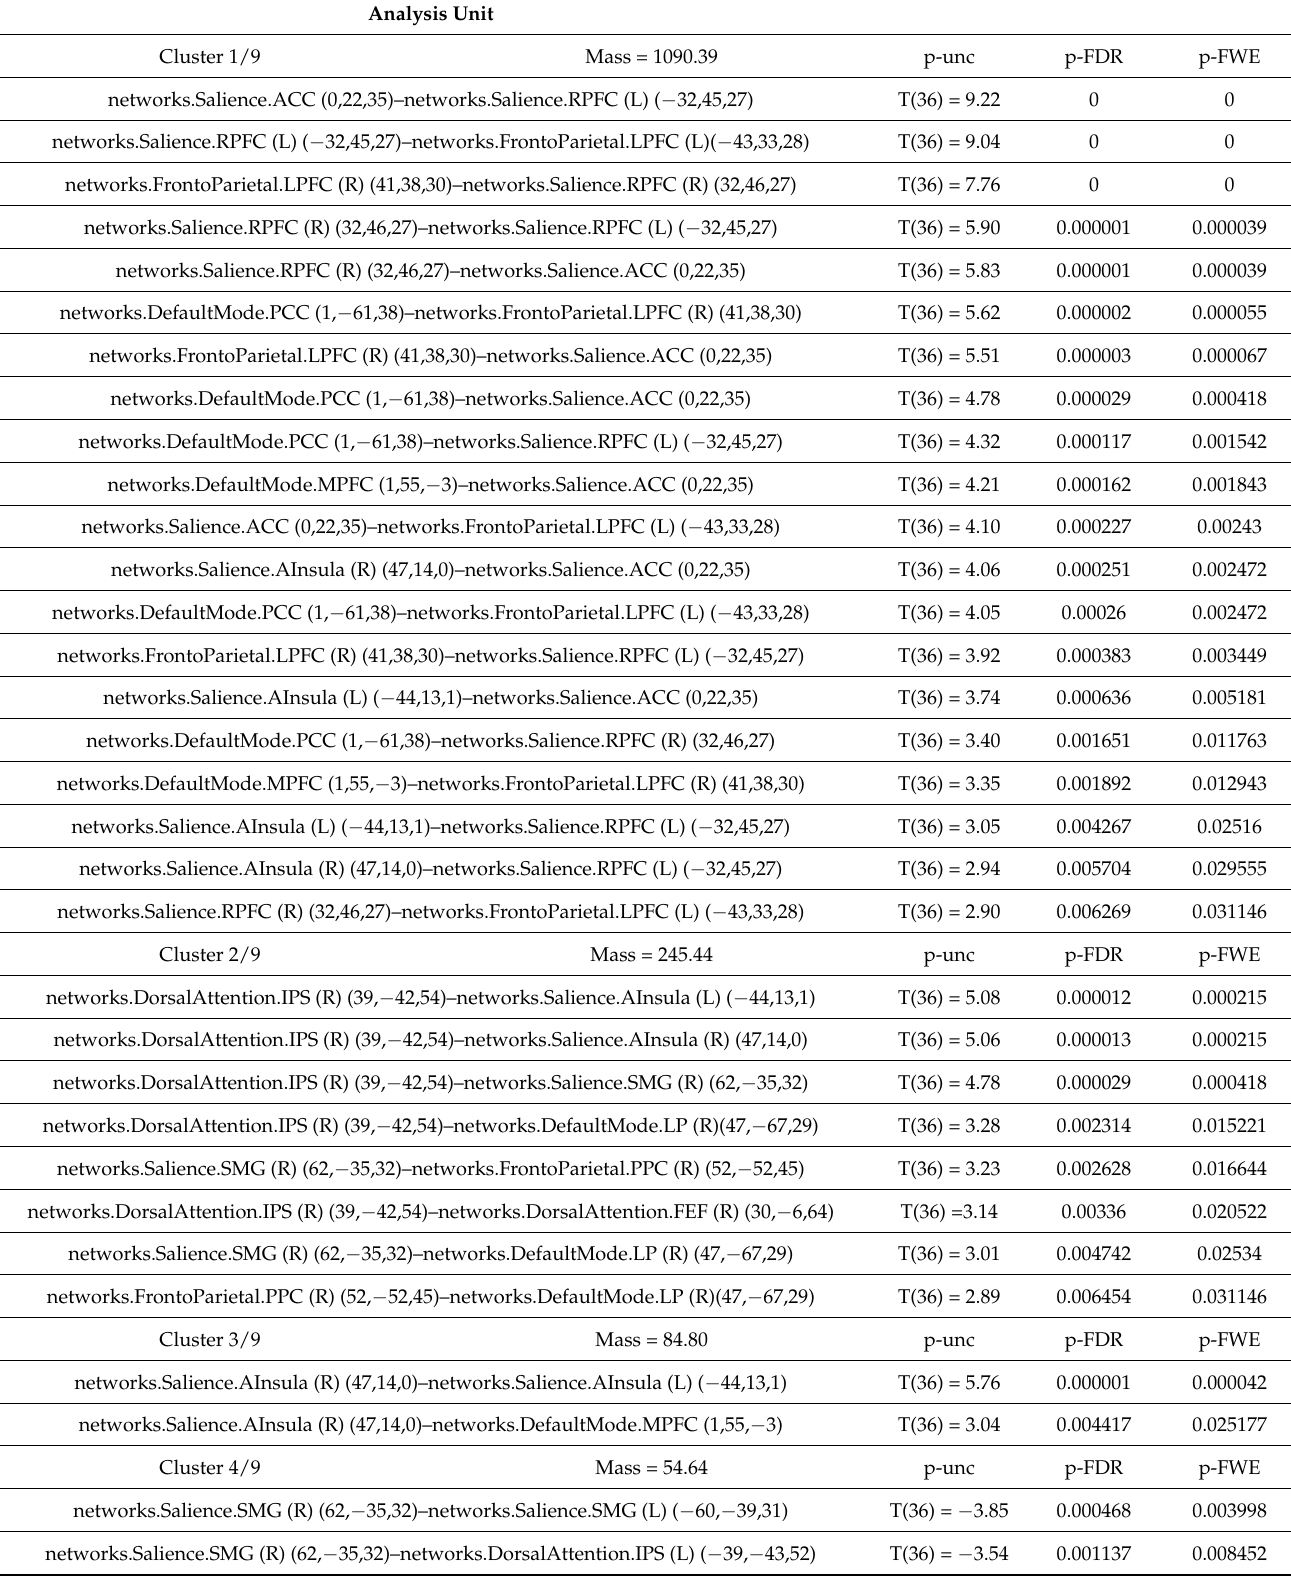
Table 2. ROI-to-ROI functional connectivity statistics of the recovery